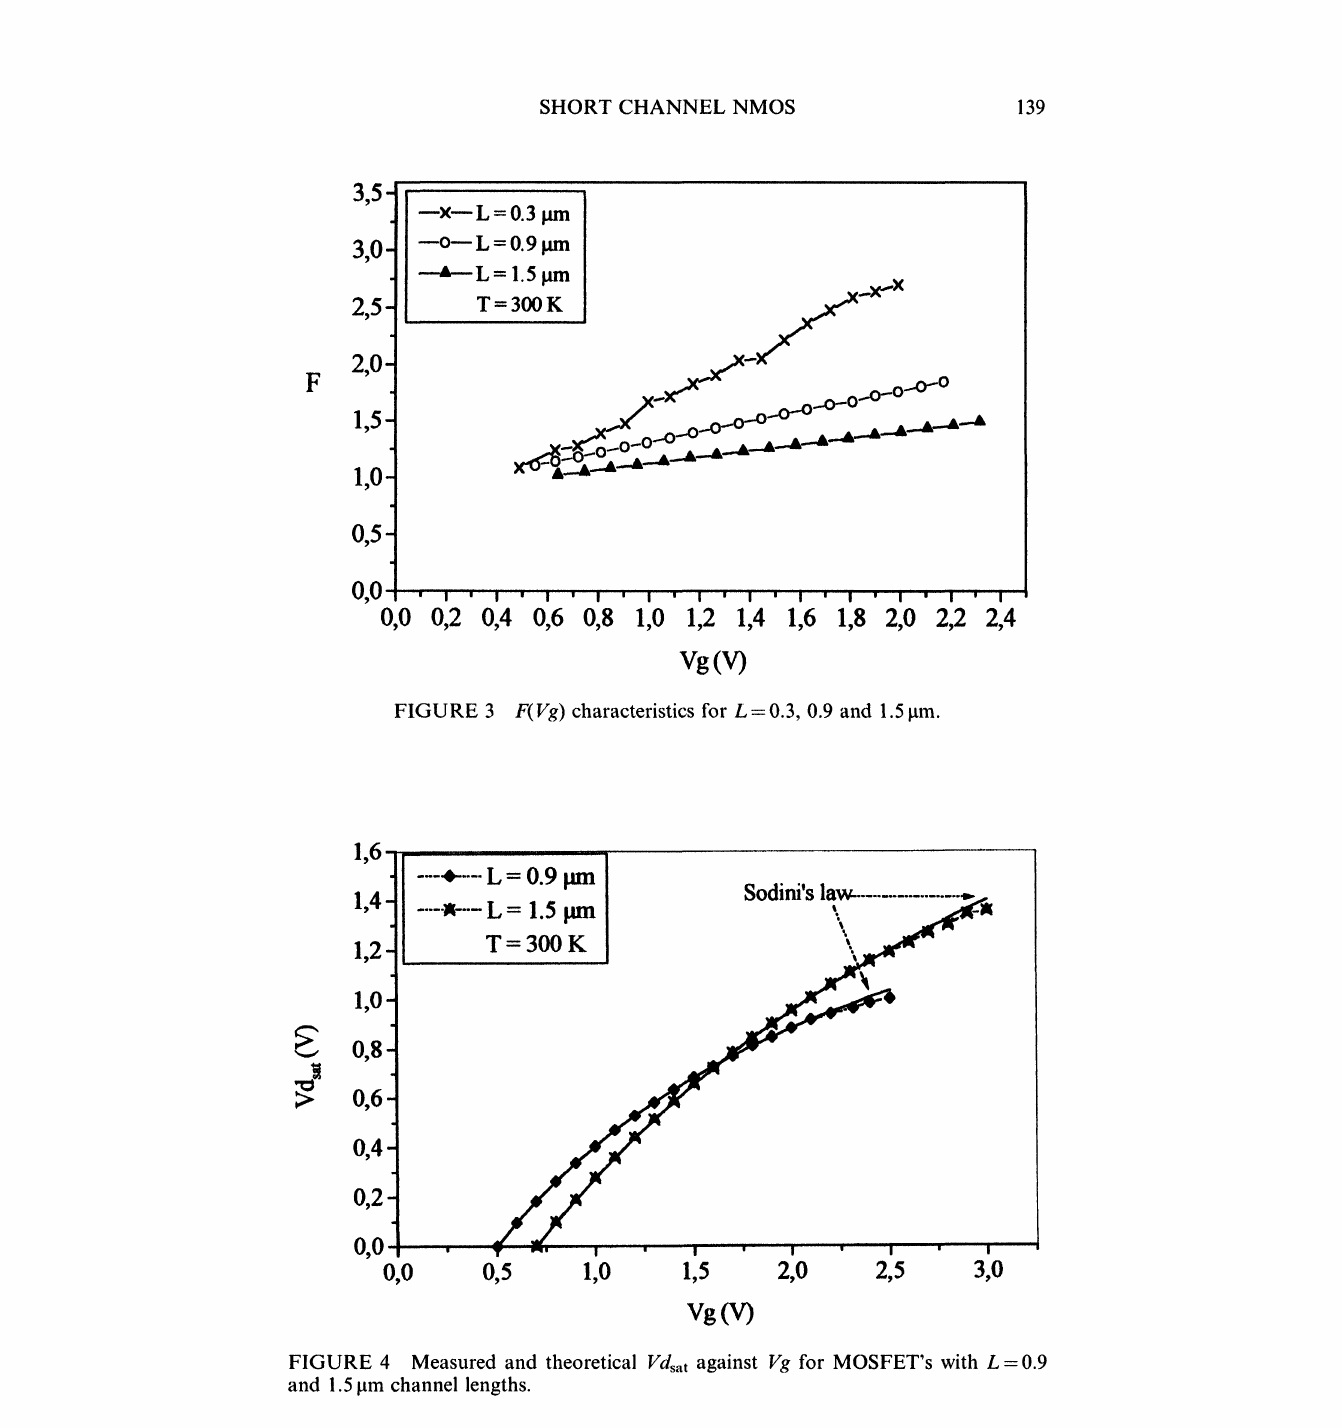
FIGURE 4 Measured and theoretical Vdsa against Vg for MOSFET’s with L=0.9 and 1.5 gm channel